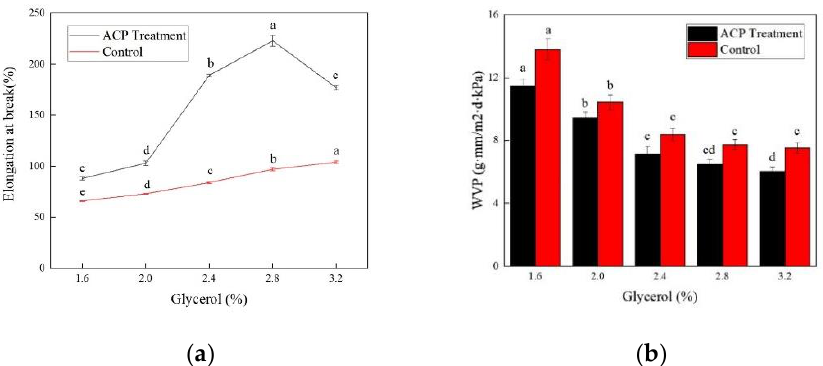
Figure 3. Effect of glycerol concentration on elongation at break and WVP of the soy protein film. ( a ) Elongation at break of ACP−treated and control group. ( b ) WVP of ACP−treated and control group. Different lowercase letters denote significant differences ( p < 0.05).